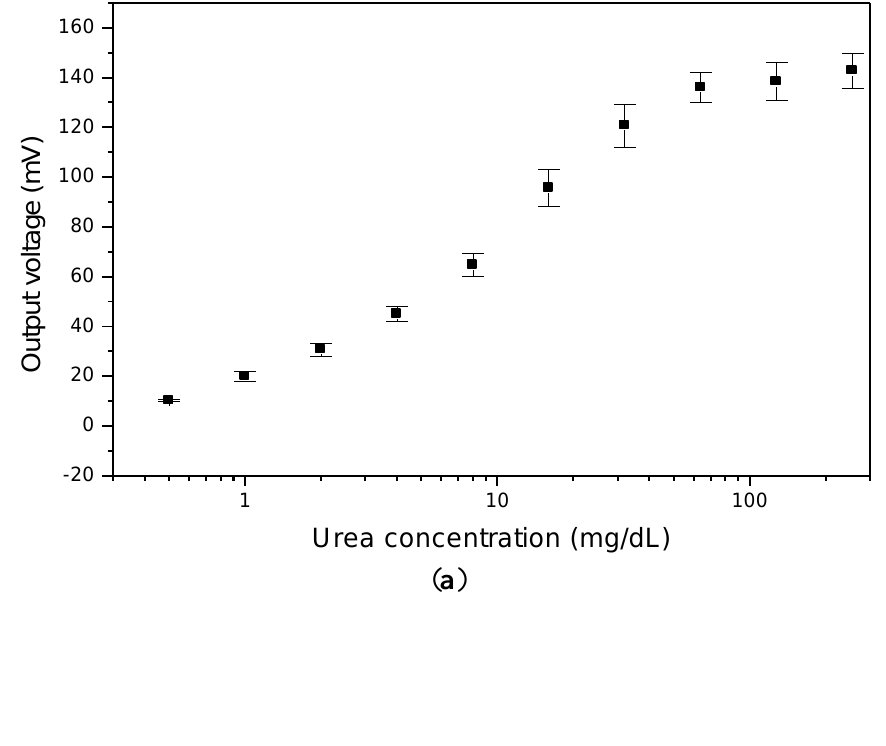
Figure 10. The output voltage for urea solutions with different concentrations. ( a ) Log scale; and ( b ) Linear